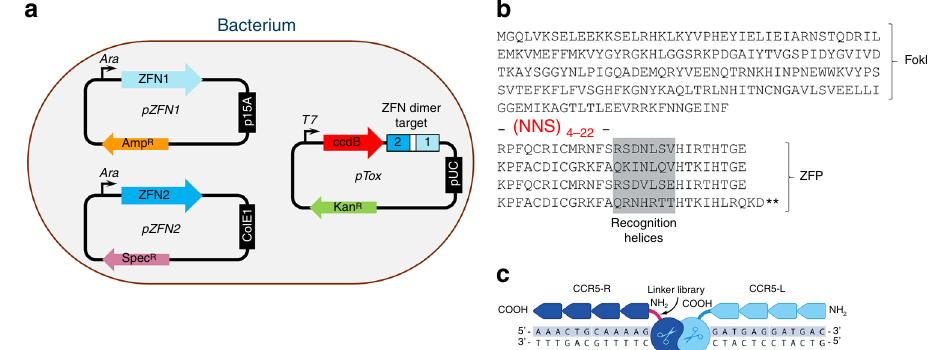
Fig. 2 Overview of bacterial selection system and library design. a Sketch of a bacterium containing plasmids used for selection. Within the pZFN1 and pZFN2 plasmids (left), each ZFN monomer is placed under control of the inducible arabinose promoter, which allows fi ne-tuning of the expression level based on the concentration of arabinose in the culture medium. Each expression plasmid contains a different antibiotic resistance marker and also compatible low-copy replication origins. Within the pTox plasmid (at right) the highly lethal topoisomerase inhibitor ccdB is expressed under control of the T7 promoter and a compatible origin of replication. pTox also contains the ZFN dimer target, cleavage of which leads to plasmid clearance. The bacterial cells used in this study express T7 RNA polymerase under control of the lac promoter. The cells also express the lac inhibitor and T7 lysozyme. b Linker library design. The amino acid sequence of the host ZFN used for selection is shown in single letter code, with the FokI cleavage domain and ZFP regions indicated. The ZFP region is shown as an alignment of the four fi ngers with recognition helices highlighted in gray. The location and composition of the randomized linker is shown in red (N = mixture of all bases, S = mixture of G and C). The randomized linker library is inserted between the carboxy- terminal residue of the FokI nuclease domain and the fi rst conserved residue in the zinc- fi nger domain. The library length varies from four to twenty-two residues. c Sketch of cleavage target used for selections. The bound ZFN dimer is shown consisting of the fi xed right-hand ZFN (CCR5-L) and the left-hand ZFN bearing the linker library (CCR5-R) with randomized linker highlighted in transcription of the polymerase gene in the absence of IPTG; is the need to completely suppress ccdB when in the uninduced (2) expression of T7 lysozyme to inactivate any low levels state. This is achieved via the use of an isopropyl β - D -1- thiogalactopyranoside (IPTG)-inducible T7 RNA polymerase of polymerase that are expressed; and (3) use of a GTG system for ccdB expression, with three safeguards against start codon in the ccdB gene, which reduces translation initiation leaky expression as follows: (1) glucose addition to suppress ~10-fold 40,41 . Selection stringency is enhanced by using